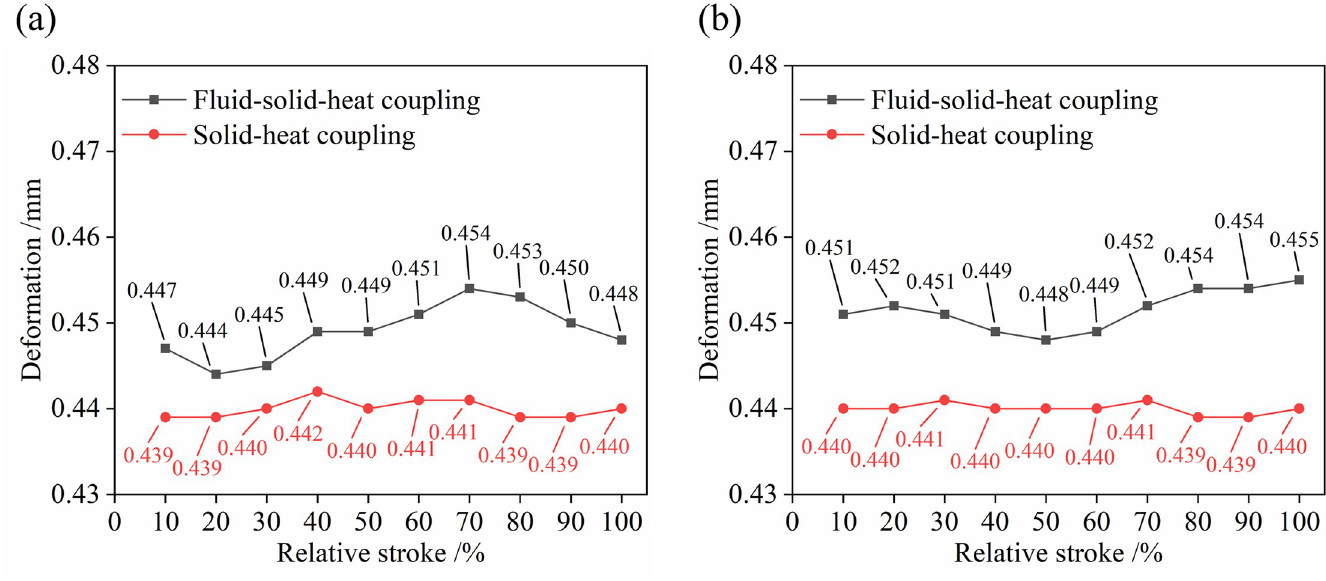
Fig 7. Comparison curves of the deformations of the matching surface. (a) Valve plug. (b) Inner sleeve.